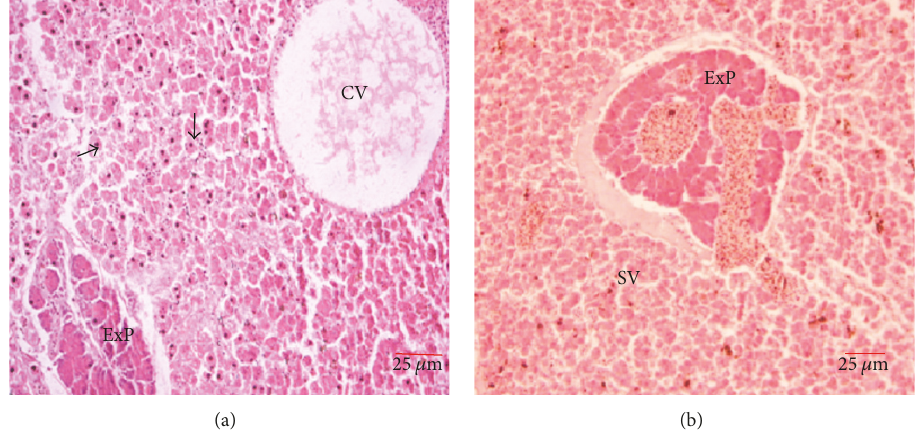
Figure 8: Liver: (a) CV, central vein, and (b) ExP, exocrine pancreas with secretory vesicles (SV), with hepatocytes arranged in irregular cords.